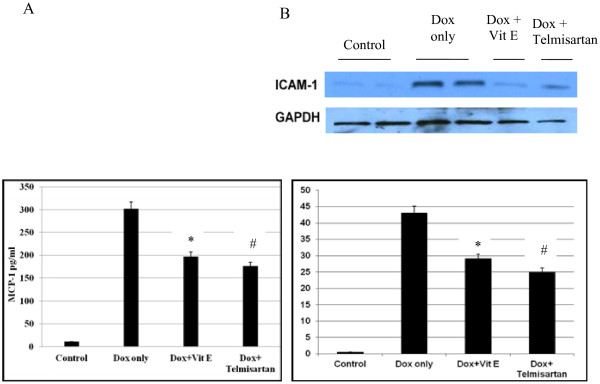
Dysfunctions of the coronary endothelium as well as injury to cardiac muscle cells are the consequences of Dox effect among many factors, MCP-1and ICAM-1 expression are released into the myocardium and circulation. Data are expressed as mean ± SEM, (A) MCP-1 #*P < 0.05; vs. Dox only (n = 8 per group). (B) While the representative western blots showing increased ICAM-1 protein expression in Dox only group #*P < 0.05; vs. Dox only (n = 8 per group).